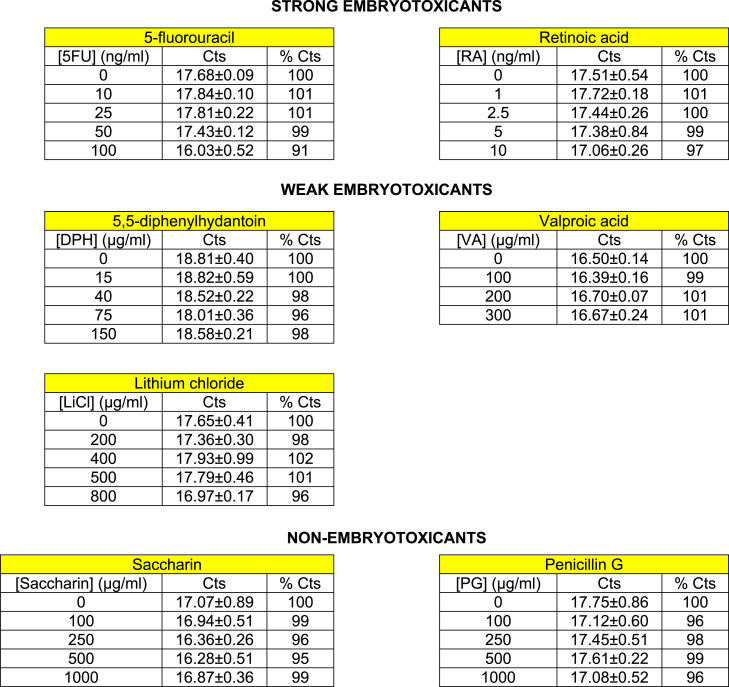
CTs recorded during actin expression. It is displayed number of number of thermal cycles needed to reach the threshold of fluorescence previously set during quantitative real time PCR experiments. It is displayed for each treatment the mean±s.d. for three biological replicates.